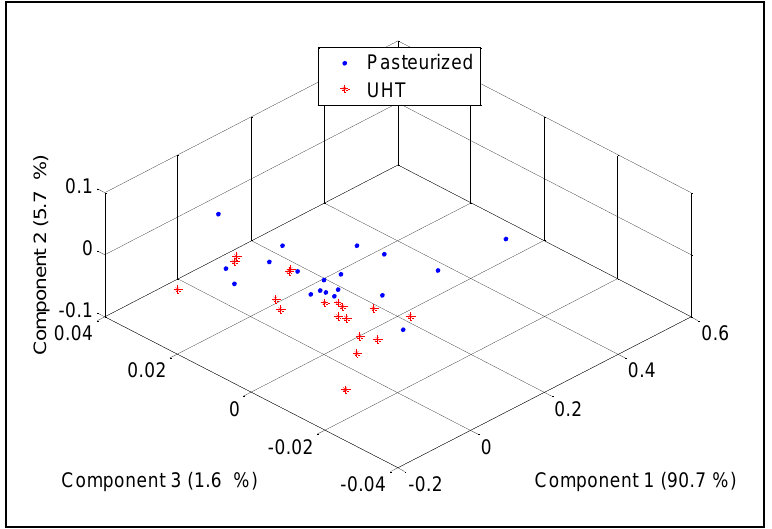
Figure 18. PCA plot for TGS26XX and TGS6812